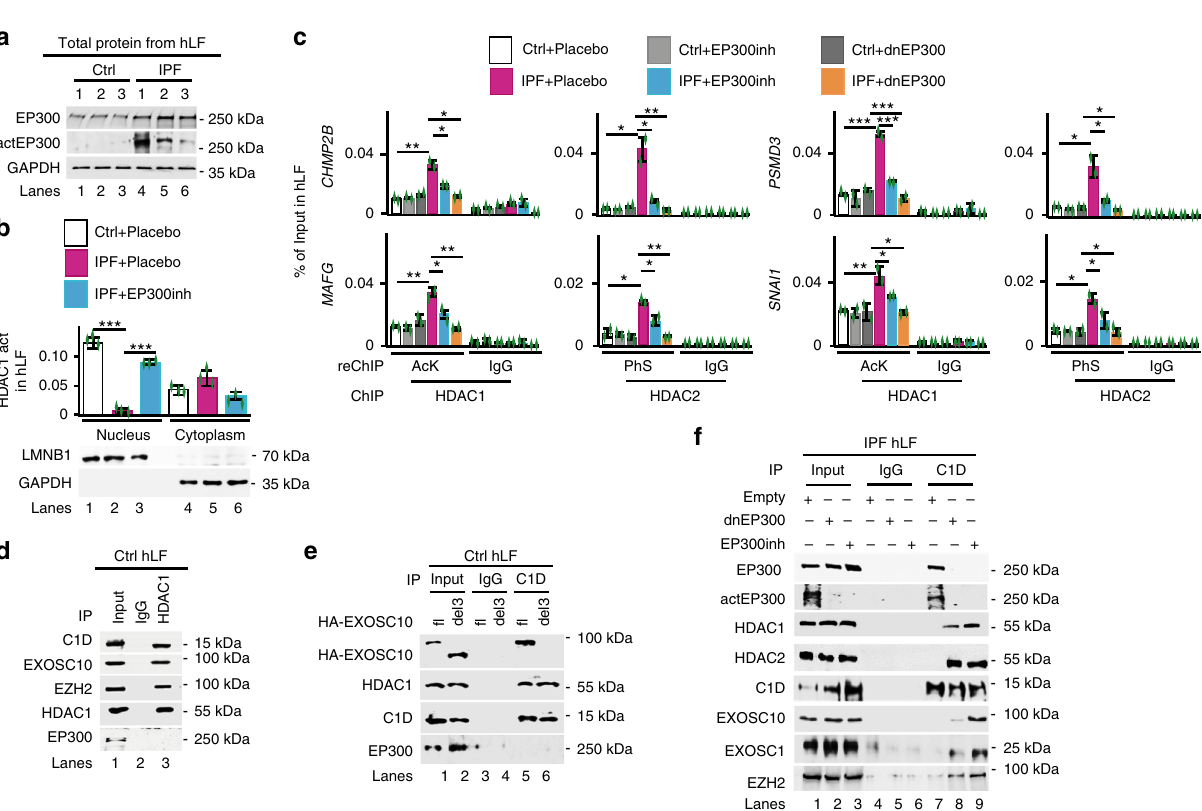
porting the causal involvement of active HDAC1 during the anti- fi brotic effects elicited by EP300 inhibition. Our results support a